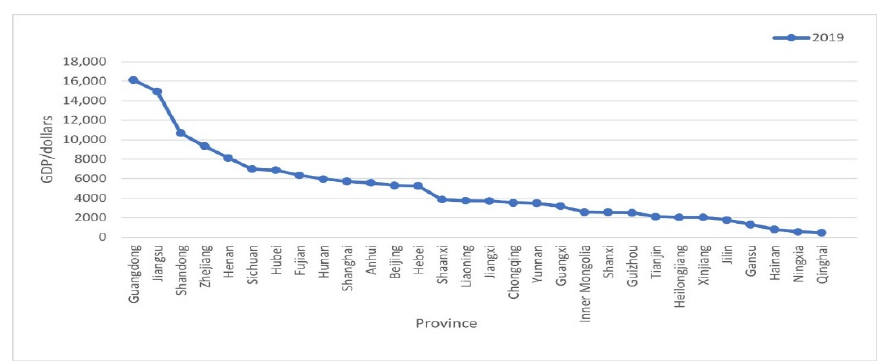
Figure 1. GDP of China’s provinces in